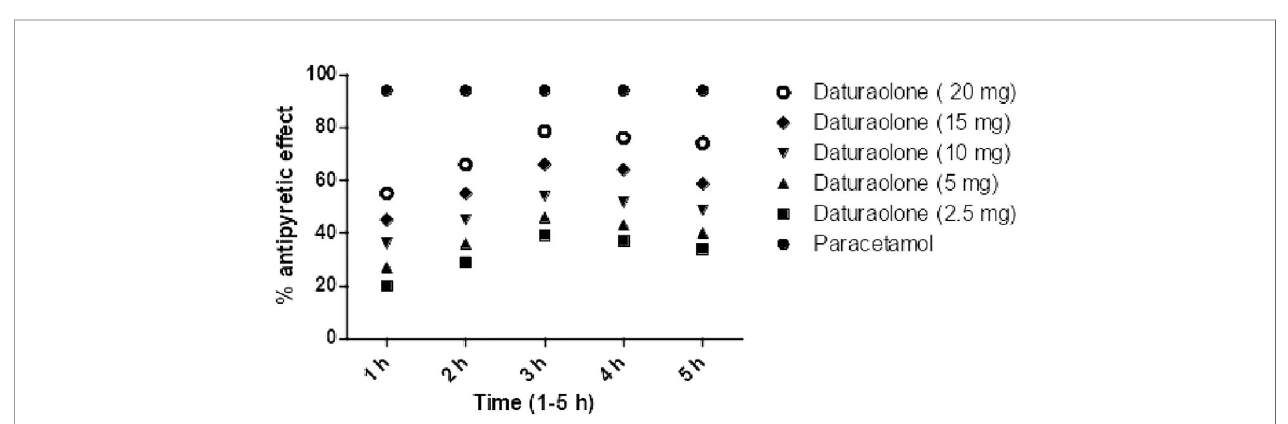
FIGURE 5 | Percent antipyretic effects of daturaolone ( 1 ) in yeast-induced test at various doses. All values are represented as the mean ± SEM for all groups of six